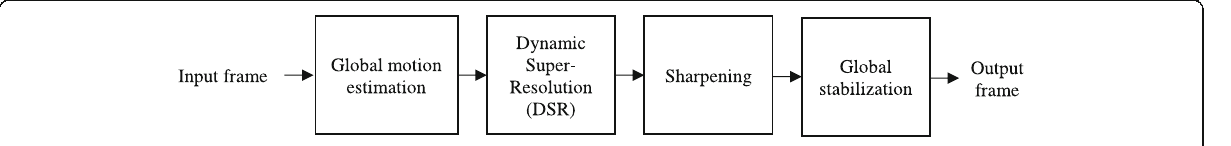
Fig. 1 Flow diagram of the TNO global turbulence mitigation method for low turbulence (i.e., r 0 ≿